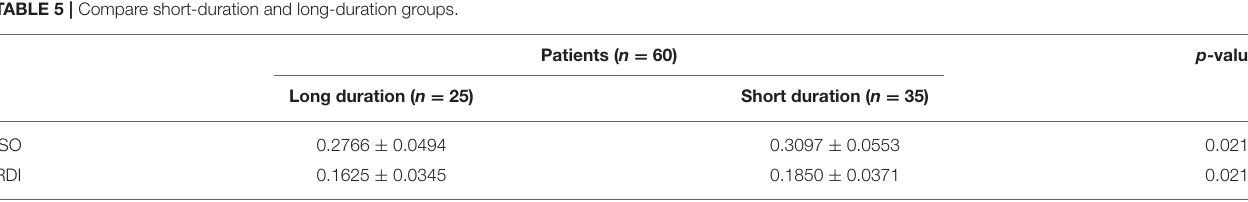
TABLE 5 | Compare short-duration and long-duration